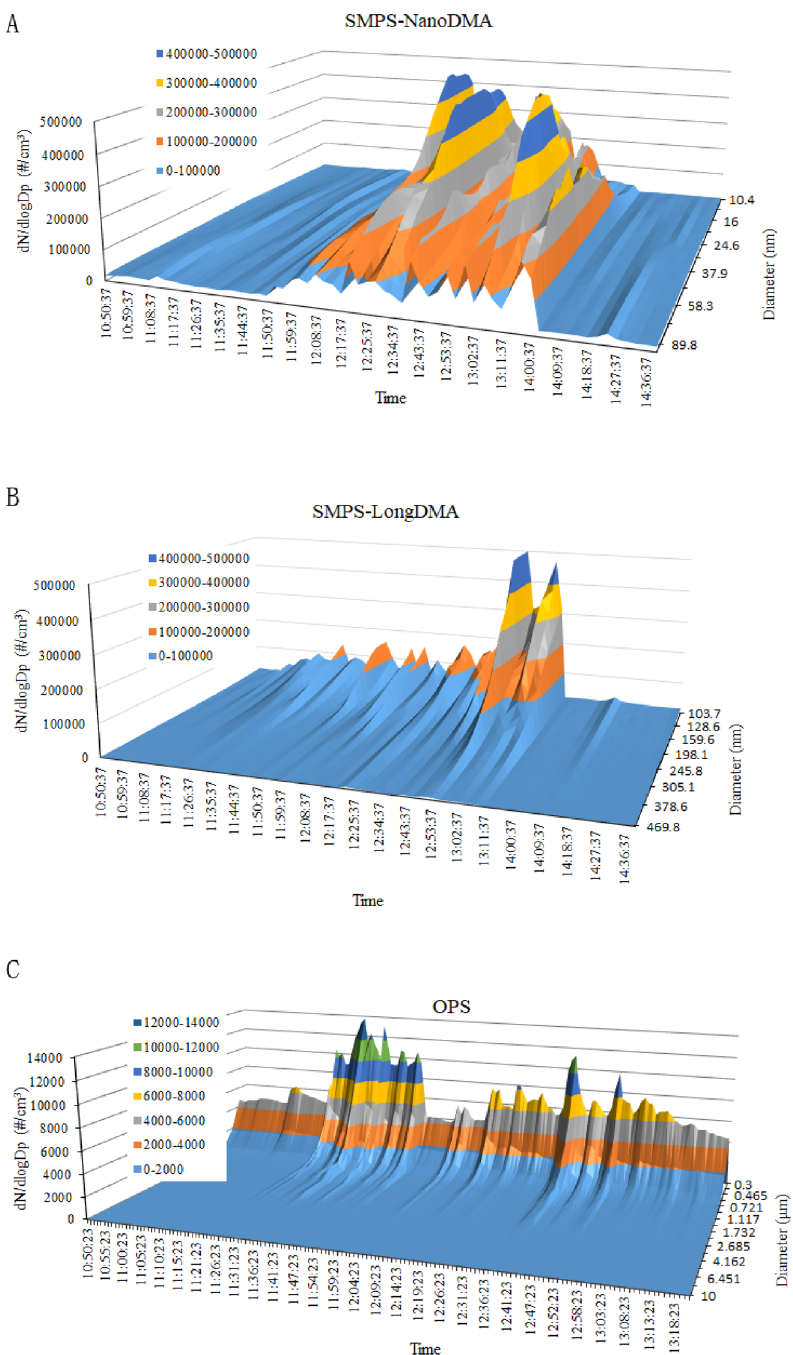
Figure 4. Real-time particle size spectrum. ( A ) scanning mobility particle spectrometer (SMPS) with Nano dust/aerosol monitor (DMA); ( B ) SMPS with Long DMA; ( C ) optical particle sizer (OPS). Most of the particles were smaller than 100 nm, and the highest number reached 5.5 × 10 5 pt/cm 3 at 10.4 nm and 100